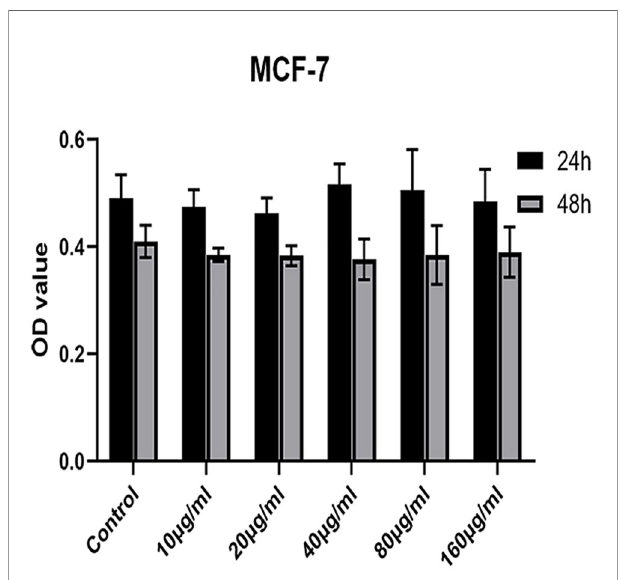
FIGURE 5 | Cell viability of MCF-7 cells incubation with MSNs-NH 2 -FA-RGD at different concentrations (µg·ml -1 ) after 24 h and 48